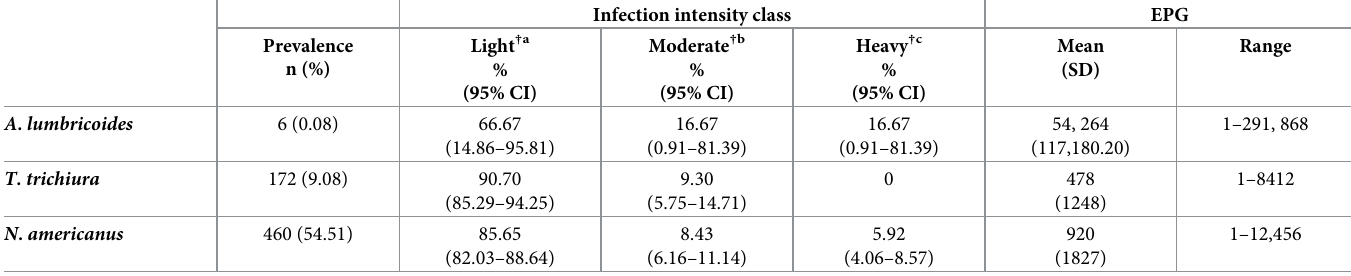
Table 3. Infection intensity of A . lumbricoides , T . trichiura , and N . americanus as measured by WHO recommended thresholds and mean eggs per gram (epg) of